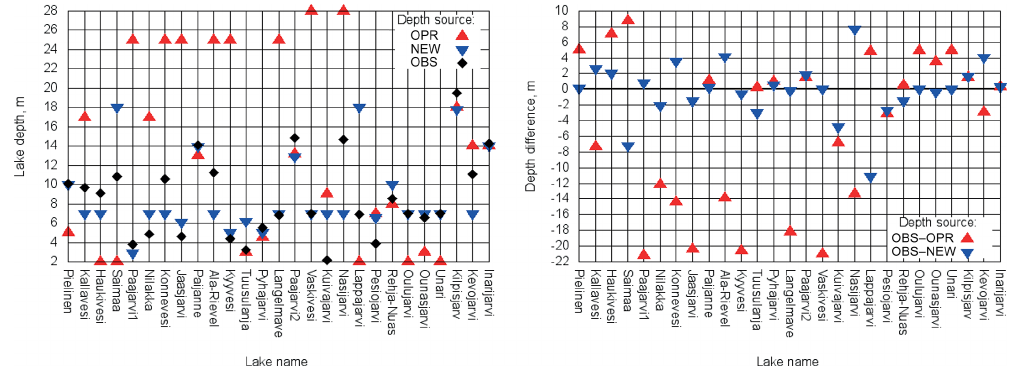
Figure 10. Lake depths and their differences in metres for 27 verification sites; OBS – measured by SYKE, OPR – from the ECMWF operational file and NEW – from the upgraded file. Table 3. Locations of 27 verification lake sites; lake morphological parameters measured by SYKE and from ECMWF Tco1279